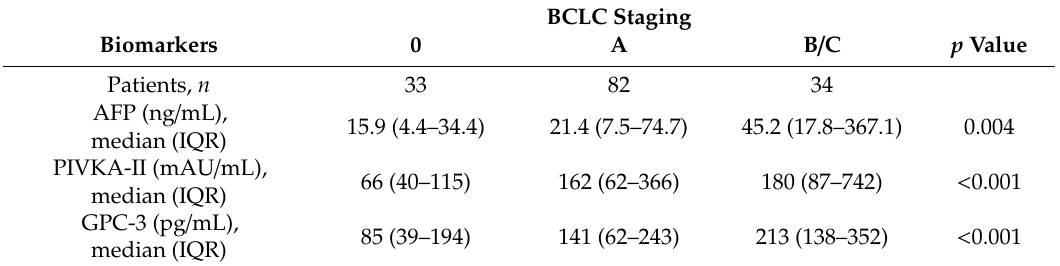
Table 2. AFP, PIVKA-II and GPC-3 serum values in patients with HCC according to BCLC stage. BCLC Staging